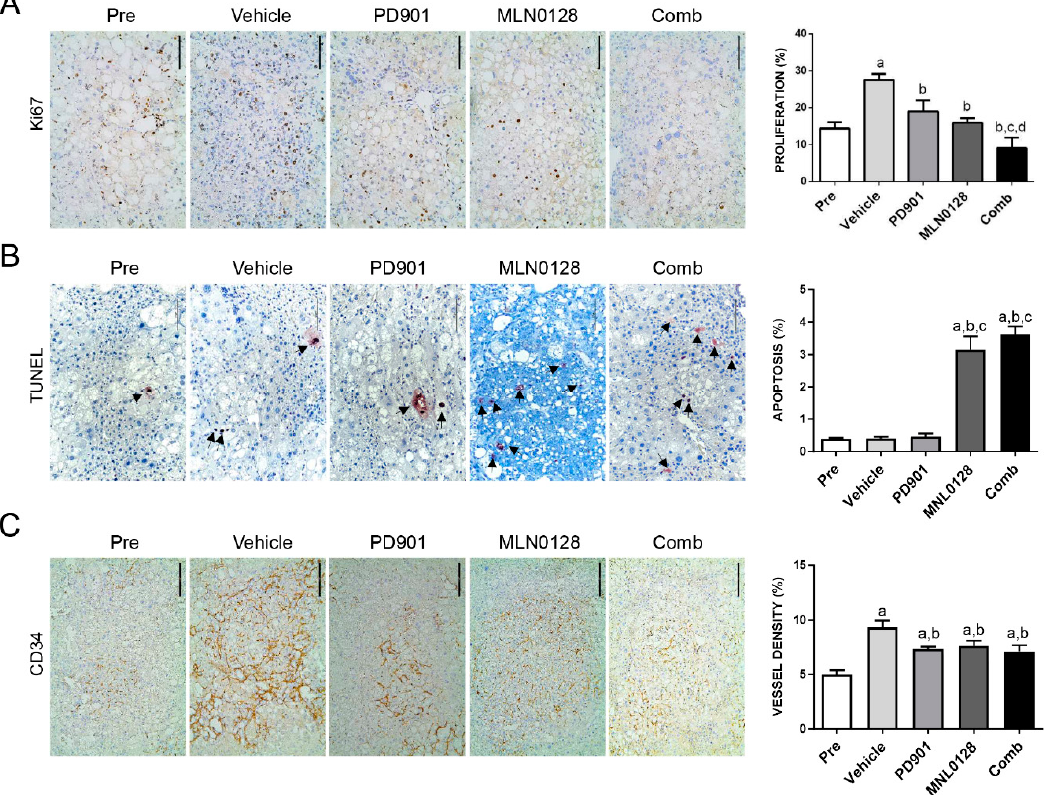
Figure 8. E ff ect of PD901 / MLN0128 combination on the lesions of AKT / c-MET mice, as determined by immunohistochemistry. ( A ) Ki-67 staining in livers from AKT / c-MET mice subjected to the various treatments. Ki-67 positive tumor cells were counted and quantified per 3000 tumor cells. ( B ) TUNEL and CD34 ( C ) staining in livers from AKT / c-MET mice subjected to the various treatments. TUNEL positive tumor cells were counted and quantified per 3000 tumor cells and indicate the apoptosis rate. The “vessel density” represents instead the percentage of CD34 staining area in each field from the sections as assessed by ImageJ software. Tukey–Kramer test: at least p < 0.01. a, vs. Pretreatment; b, vs. Vehicle; c, vs. MLN0128; d, vs. PD901. Abbreviations: Pre, Pre-treatment; Comb, combined PD901 / MLN0128 treatment.